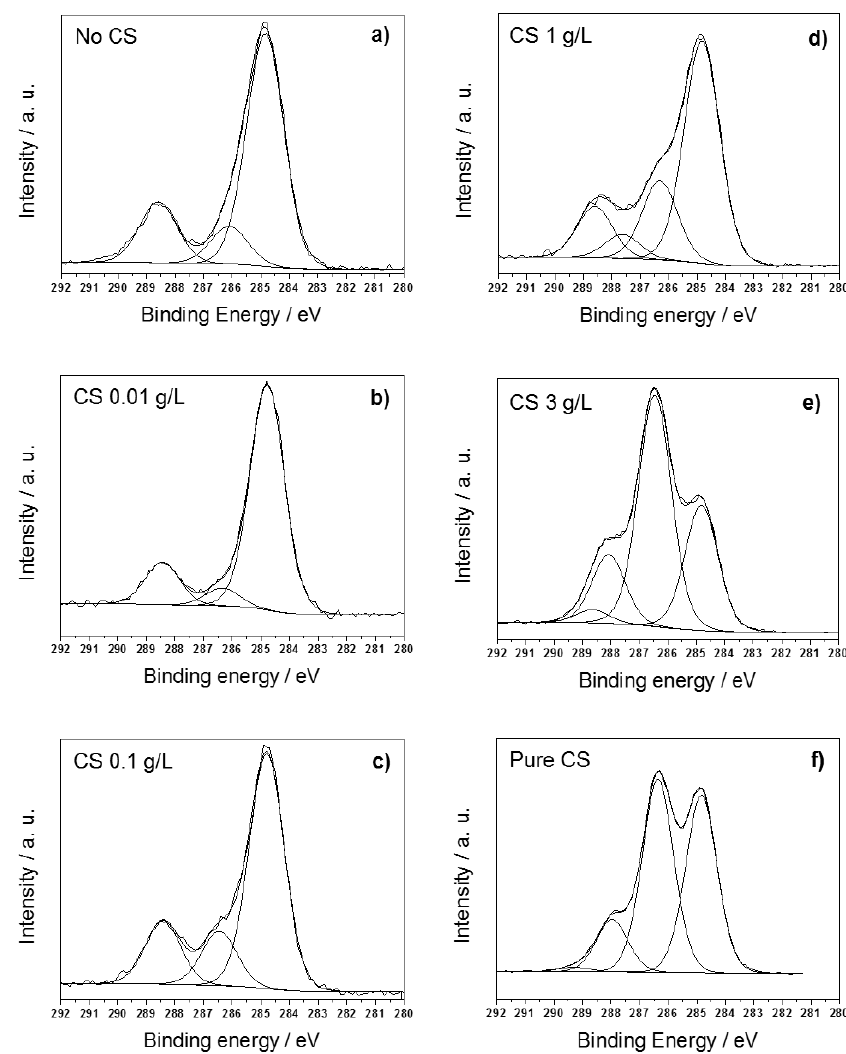
Figure 2. C1s high-resolution regions of freshly-prepared CuNPs-CS nanocomposites synthetized at a CS concentration of: ( a ) no CS; ( b ) 0.01 g/L; ( c ) 0.1 g/L; ( d )1 g/L; ( e ) 3 g/L; ( f ) pure